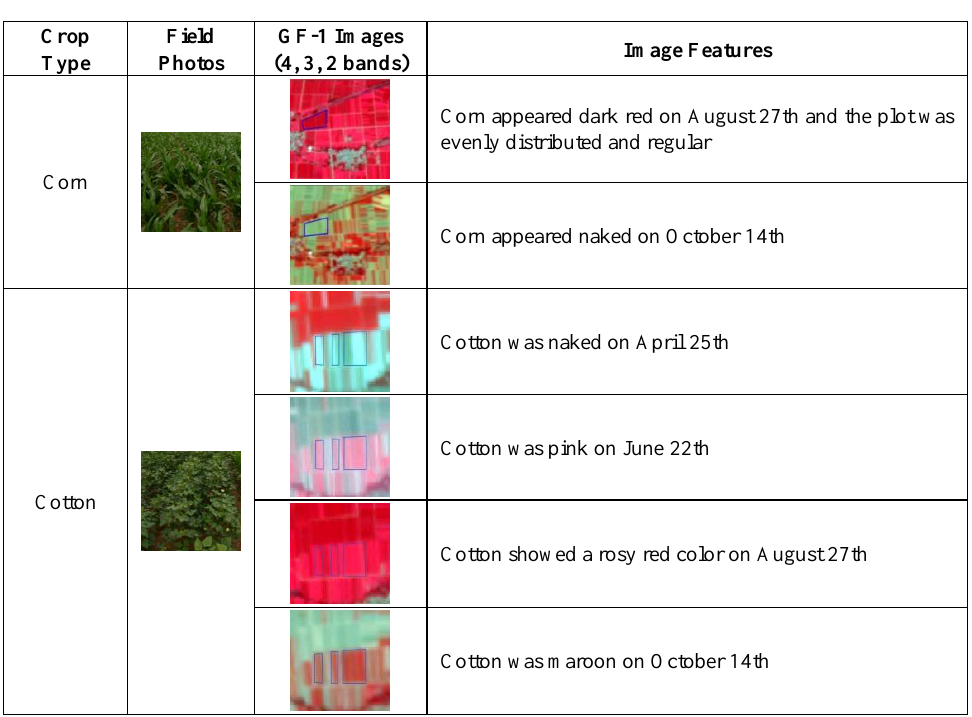
Table4. The characteristics of interpretation of main harvesting crops in Jinxian County